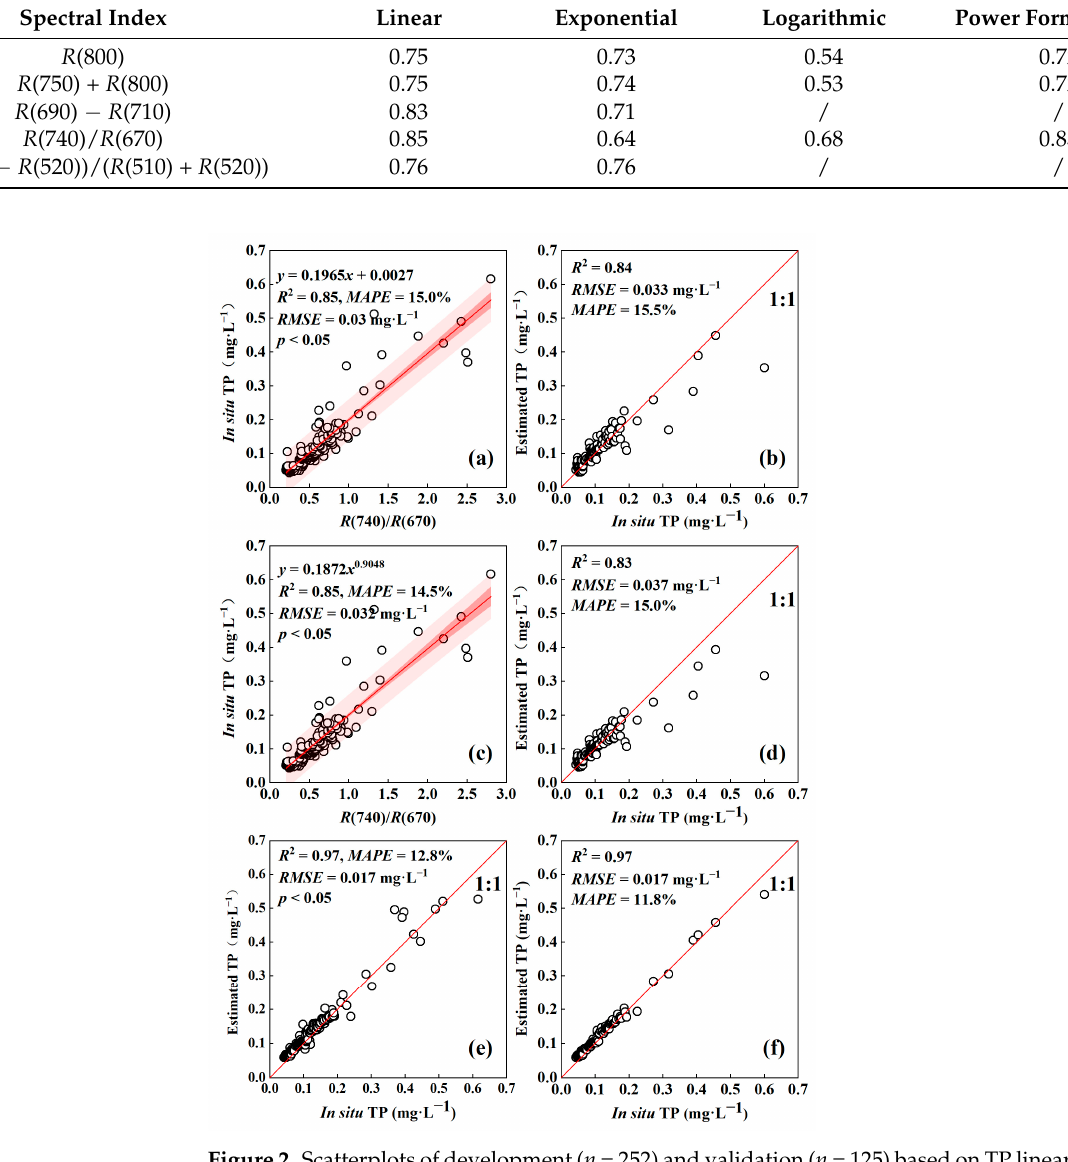
Figure 2. Scatterplots of development ( n = 252) and validation ( n = 125) based on TP linear model ( a , b ), power exponential model ( c , d ) and the XGBoost model ( e , f